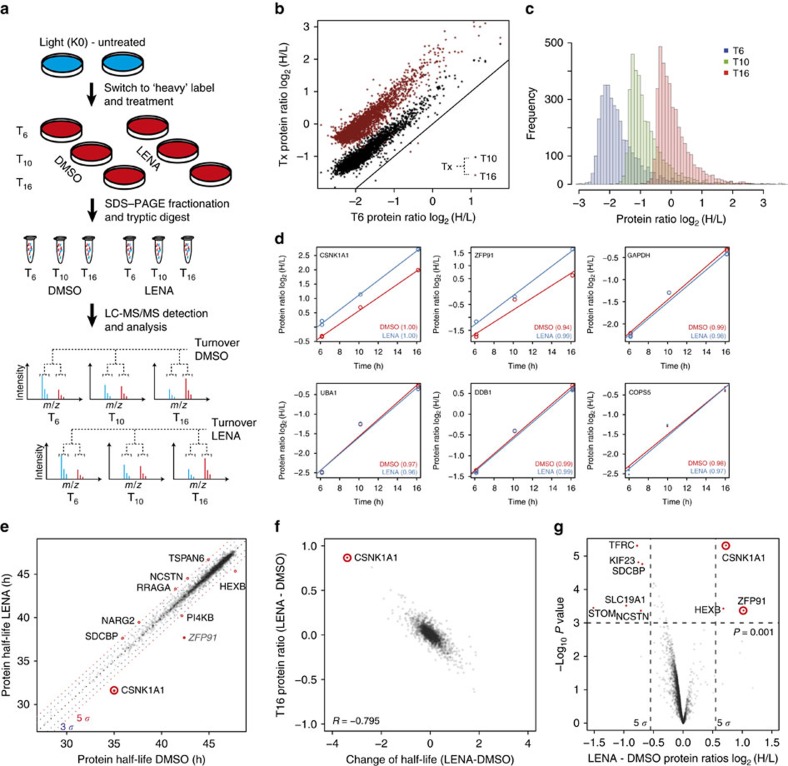
Multi time point pSILAC mass spectrometry.(a) Outline of the multi time point pulse-SILAC mass spectrometry experimental design. For simplification, replicate and reverse experiments are not depicted in this figure. (b) Scatter plot depicting the change of H/L protein ratios over time. Protein ratios of the 10 and 16 h time points are compared to the 6 h time point. Data in this figure are presented as means of biological replicates for T6 and T16 (n=2) or individual data points for T10 (n=1). (c) Frequencies of H/L protein ratios at different time points (data as in b). (d) Plots depicting the logarithmic H/L protein ratios over time are shown for the two validated targets CSNK1A1 and ZFP91 as well as for control proteins GAPDH, UBA1, DDB1 and CopS5. Differential turnover for CSNK1A1 and ZFP91 is observed, while stable conditions are found for controls. Data in this figure are presented as individual data points and separate r2 values for the linear regression are provided for lenalidomide and DMSO samples. (e) Scatter plot comparing protein half-lives of lenalidomide treated and control samples. Protein half-lives were obtained by fitting the H/L protein ratios of T6 (n=2), T10 reverse (n=1) and T16 (n=2) time points to a decay function24. For further analysis, we retained only proteins quantified in all samples and with r2>0.9 for both linear regression fits (DMSO and lenalidomide treated), resulting in a total of 2,759 proteins. CSNK1A1 was found to exhibit a reduced half-life in presence of lenalidomide. Blue and red dotted lines indicate ±3 and ±5 s.d., respectively. ZFP91 was dropped from the data analysis for missing values in two replicate measurements. The depicted delta-half-life for ZFP91 is calculated using imputed values from replicates to replace the missing values. (f) Scatter plot depicting the negative correlation between differences in protein half-life (data as in e), and differences in log2 H/L protein ratios at the T16 time point (LENA-DMSO, mean of two biological replicates). R corresponds to the Pearson's correlation coefficient. (g) Fold change in H/L ratios comparing lenalidomide to DMSO control treatment on the x axis (HEK293 T16 SILAC samples). Moderated t-test P values were calculated using the limma package and shown as −log10 values on the y axis. The vertical dashed lines indicate ±5 s.d. log2 fold change in H/L ratio and the horizontal dashed line indicates P value <0.001. Data shown represents two biological replicates.